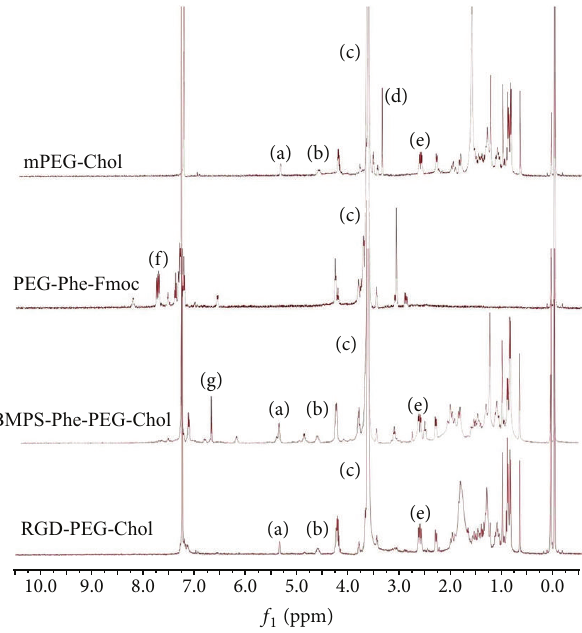
Figure 1: 1 H-NMR spectra of mPEG-PEG, PEG-Phe-Fmoc, BMPS- Phe-PEG-Chol, and RGD-PEG-Chol in CDCl 3 . (a, b) 6- and 3- position protons in cholesterol; (c) the repeating units of methoxyl inmPEGorPEG;(d)theprotonsintheterminalgroupofmPEG;(e) methylene proton of succinyl group; (f) protons in the Fmoc group; (g) protons on maleimidyl group of